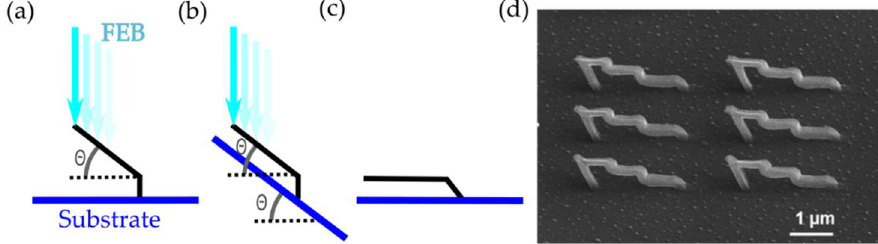
Figure 8. Use of substrate tilt during growth. ( a ) Example nanostructure grown at an angle θ on a flat substrate; ( b ) Nanostructure ( a ) grown using a substrate tilt of θ; ( c ) Result of growing nanostructure ( b ); ( d ) Example of ‘staircase’ nanostructures grown using substrate tilt.